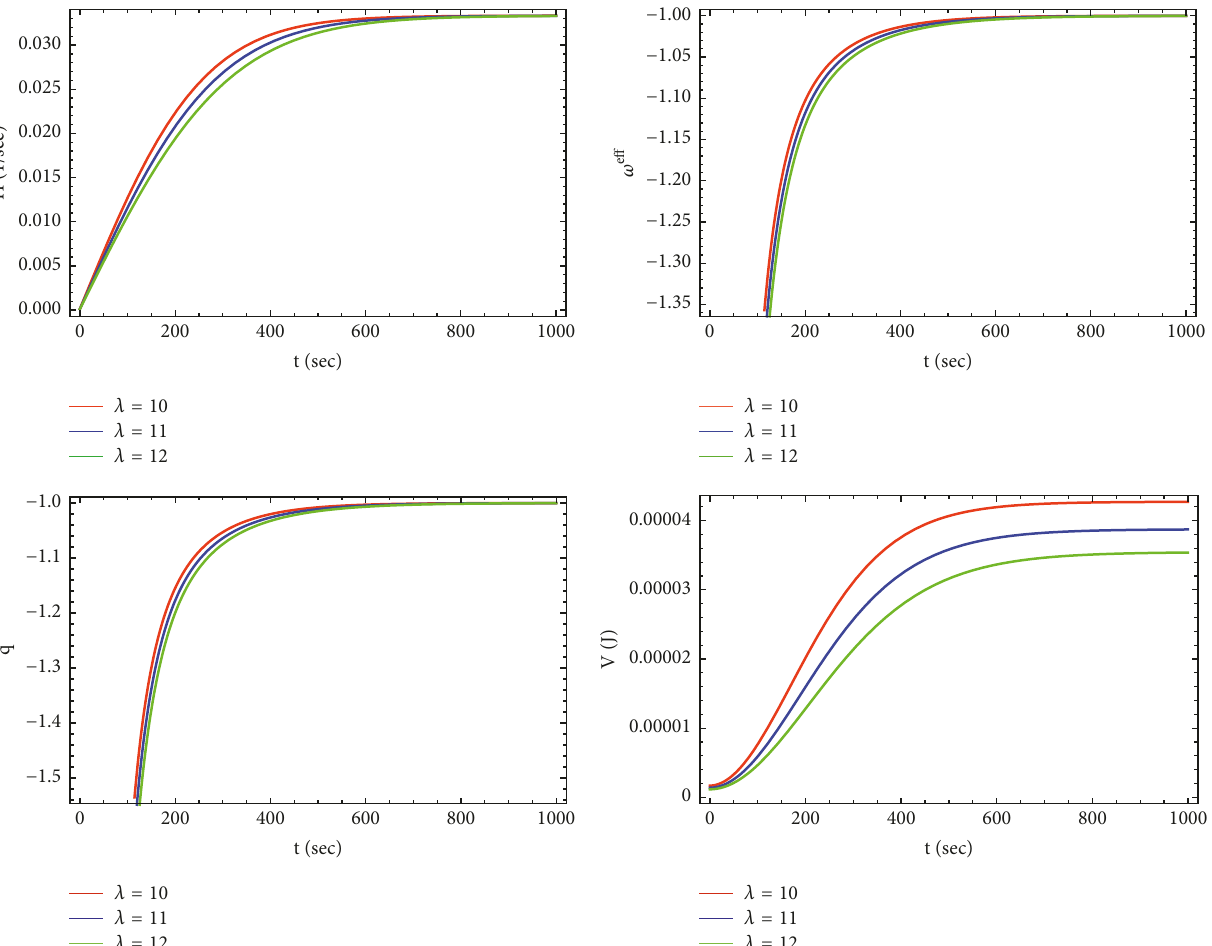
Figure 2: Plots of 𝐻 , 𝜔 𝑒𝑓𝑓 , 𝑞 , and 𝑉 versus 𝑡 for 𝑊(𝜑) = 𝑏 2 (𝜑 2 /3 − 𝜑) , 𝑏 2 = 0.05(1/𝑠𝑒𝑐) , and 𝑐 2 = 1 when 𝑘 = 0